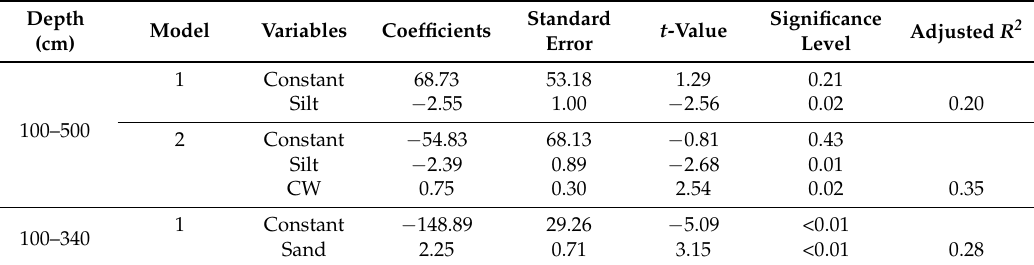
Table 4. Stepwise multiple linear regression for